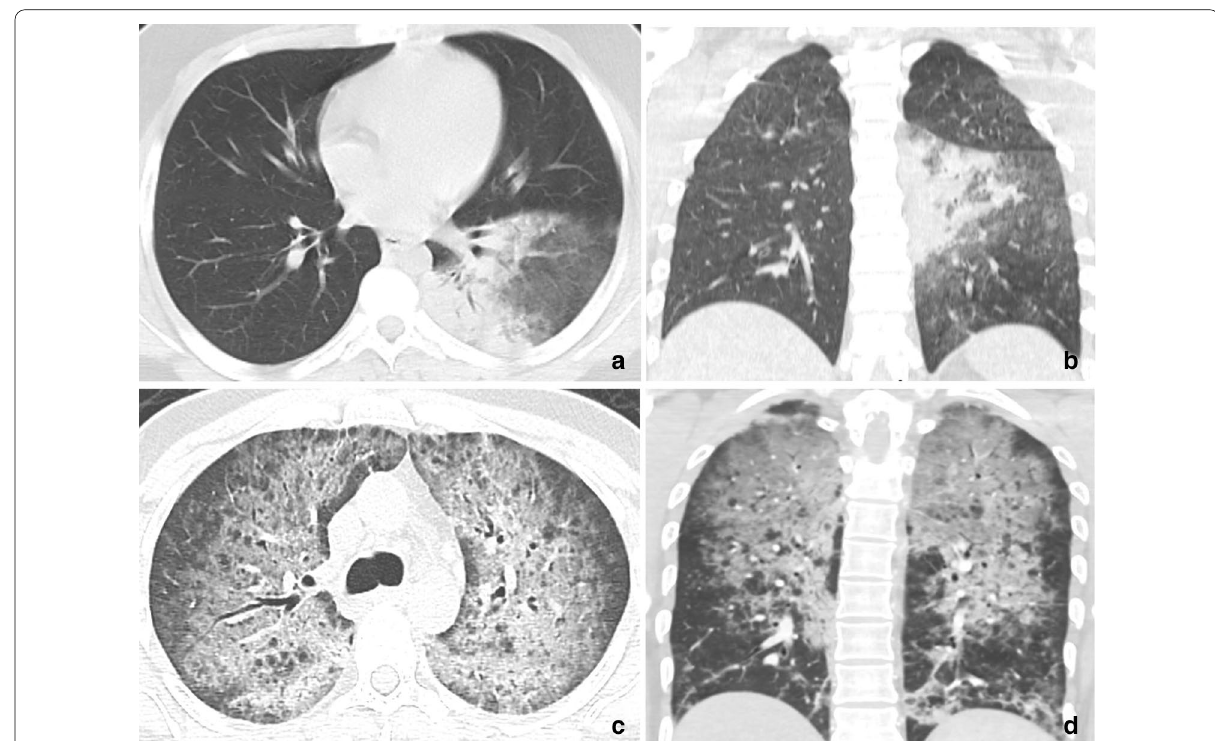
Fig. 8 Atypical infection mimicking indeterminate COVID‑19 and viral pneumonia mimickers. a , b A 39‑year‑old man with Mycoplasma pneumonia, axial and coronal reformatted CT images shows unilateral lobar consolidation with nearby GGO and centrilobular nodules. c , d Pneumocystis jirovecii pneumonia in a 36‑year‑old man with positive HIV test, axial and coronal reformatted CT images show extensive bilateral ground‑glass opacities with relative subpleural